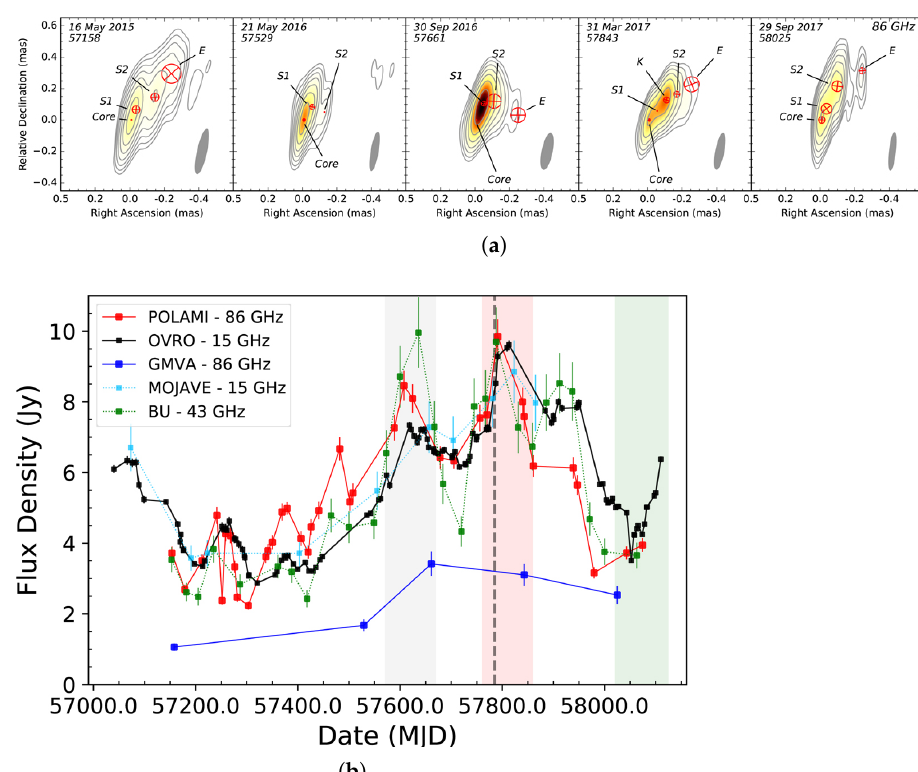
Figure 6. Time evolution of the blazar OJ 287 on parsec-scale, showing the appearance of a new VLBI feature (knot K) in the jet following the first ever VHE flare detected from this source during the period 1–4 February 2017, and the occurrence of a high radio emission state around the TeV activity. ( a ) Total intensity VLBI images at five epochs from 86 GHz GMVA observation. Red circles represent the model fit components. The new feature K appeared in March 2017, at 0.2 mas from the radio core, between the two quasi-stationary components S1 and S2. ( b ) Multiwavelength radio light curves from 2015 to 2017. The vertical dashed line shows the time of the VHE flaring state and shaded areas the periods of enhanced activity. The TeV detection was also coincident with increased activity in the X-ray and gamma-ray ranges. Credit: [147], A&A, reproduced with permission